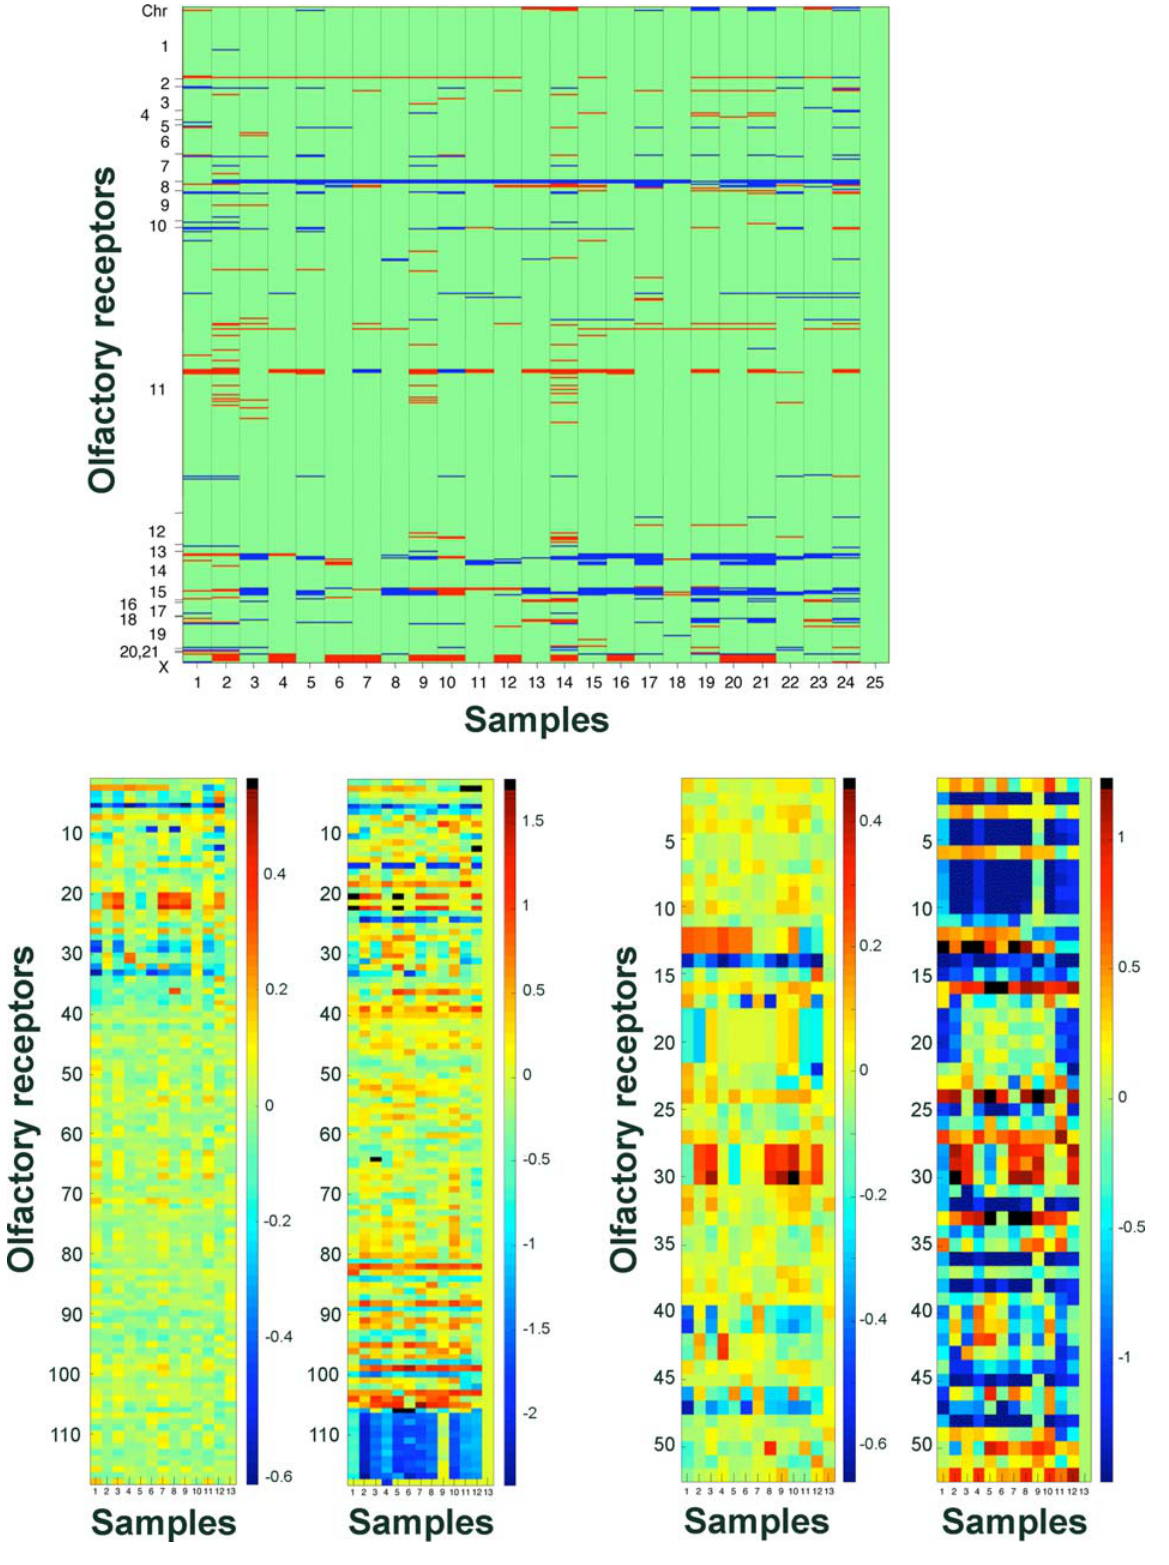
Figure 1. A high-resolution map of CNVs in the human OR repertoire. A) CNV map for OR loci based on high-resolution oligonucleotide tiling arrays. 851 ORs are ordered according to their location along the chromosomes, as indicated on the left; rows represent genes, columns are individuals; gains are shown in red, losses in blue and un-changed dosage in green (calls were made relative to the male reference individual NA19154). Note that the non-uniform genomic distribution of ORs results in an unbalanced representation of chromosomes in panel A. Also, note that ‘gains’ on chromosome X do not represent CNVs but refer to the expected male/female dosage difference. CNV calls are given for all 25